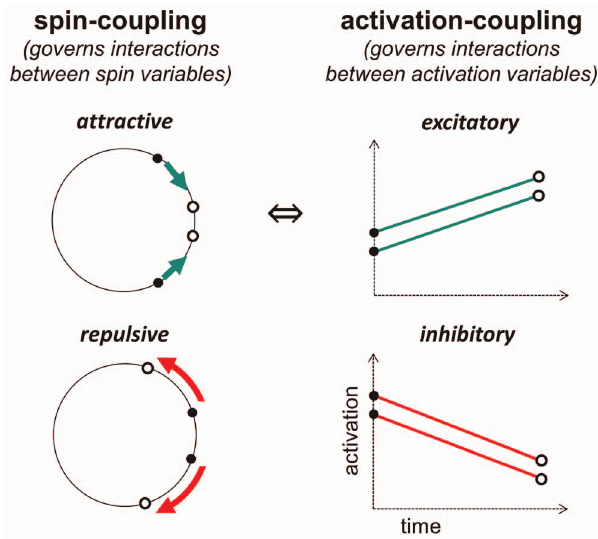
Figure 4. Schematic illustration of effects of spin-coupling and activation coupling. Spin-coupling forces act to decrease or increase the phase difference between oscillatory systems. Activation-coupling forces act mutually to increase or decrease